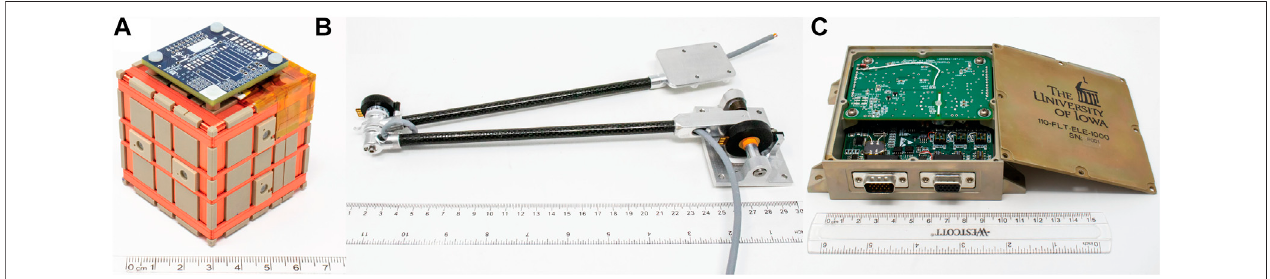
FIGURE 7 | (A) Prototype magnetometer sensor for TRACERS. (B) BLAZE magnetometer boom. (C) Fluxgate electronics as- fl own on the ICI-5 sounding rocket (November